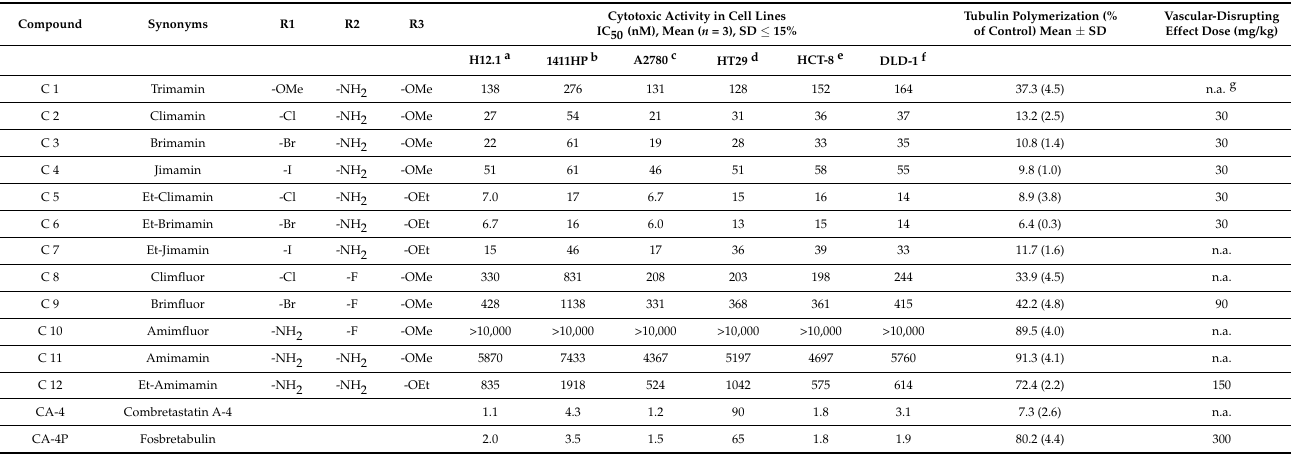
Table 1. Characteristics of compounds: specific substituents, IC 50 (96 h) values of cytotoxicity assays, values of tubulin polymerization assays, and doses to induce vascular-disrupting